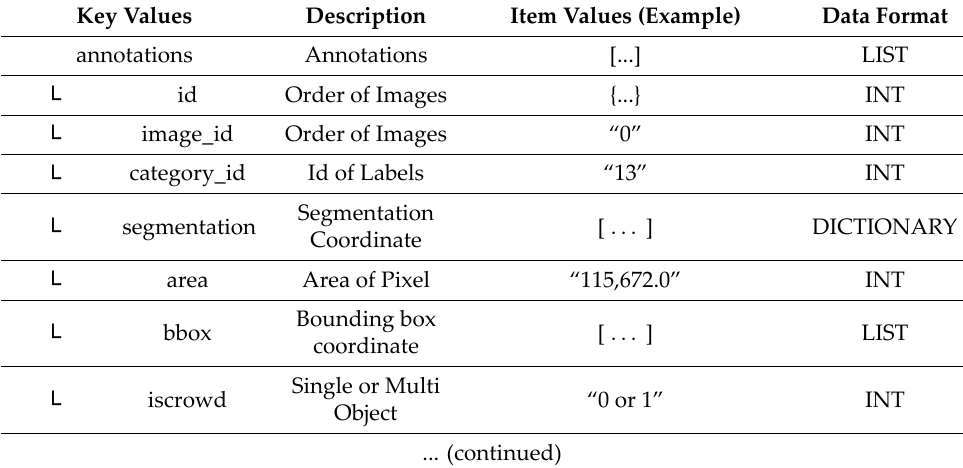
Table 3. COCO Format metadata for training.